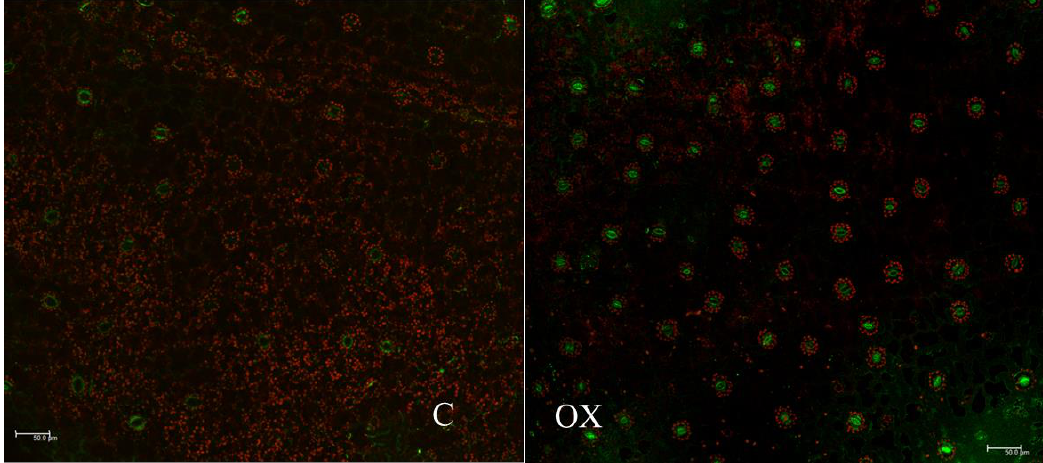
Figure 8. Localization of GFP in flowers of vector control (transformed with 35S-GFP construct) and PI3K-GFP overexpressed Nicotiana tabacum by confocal laser scanning microscopy. Control (C) and PI3K-overexpression (OX) line. GFP fluorescence is clearly visible in the guard cells of flowers from PI3K overexpressed plants. Scale represents 50.0 µm.